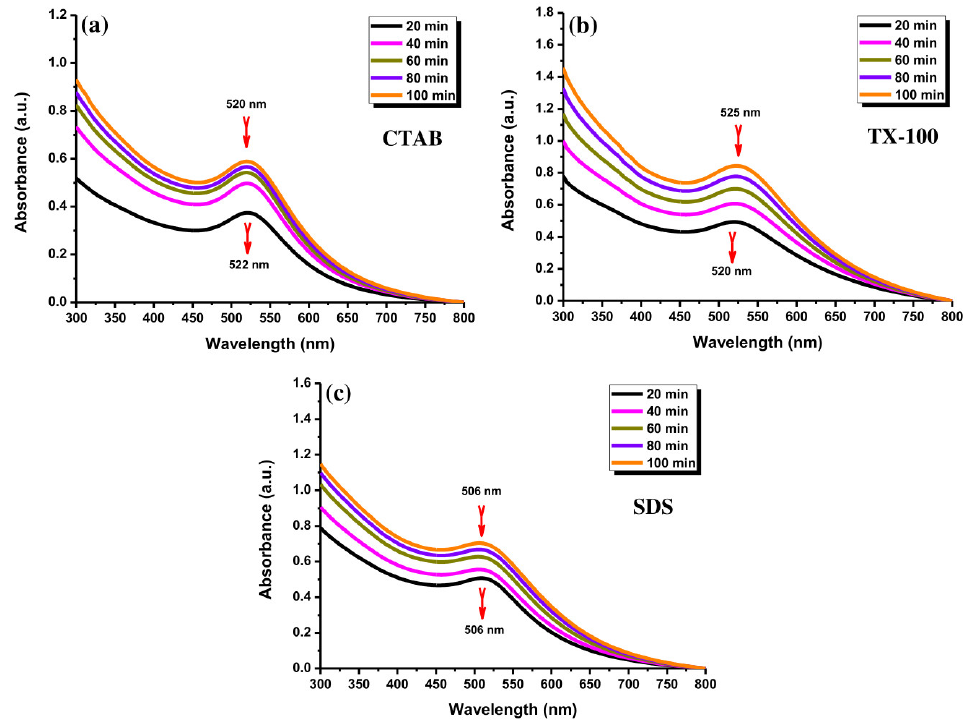
Figure 5. The UV-Vis absorption spectra of Au NPs using ( a ) CTAB, ( b ) TX-100, and ( c ) SDS (10 mM) with different laser ablation times (20, 40, 60, 80, and 100 min) at laser fluence of 0.4 J cm −2 .